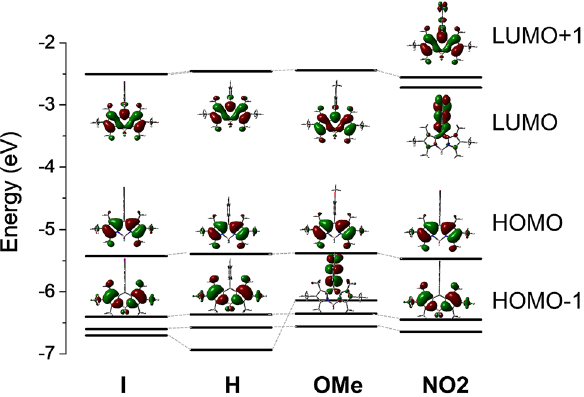
Figure 4. Energy diagram of frontier molecular orbitals of the BODIPY